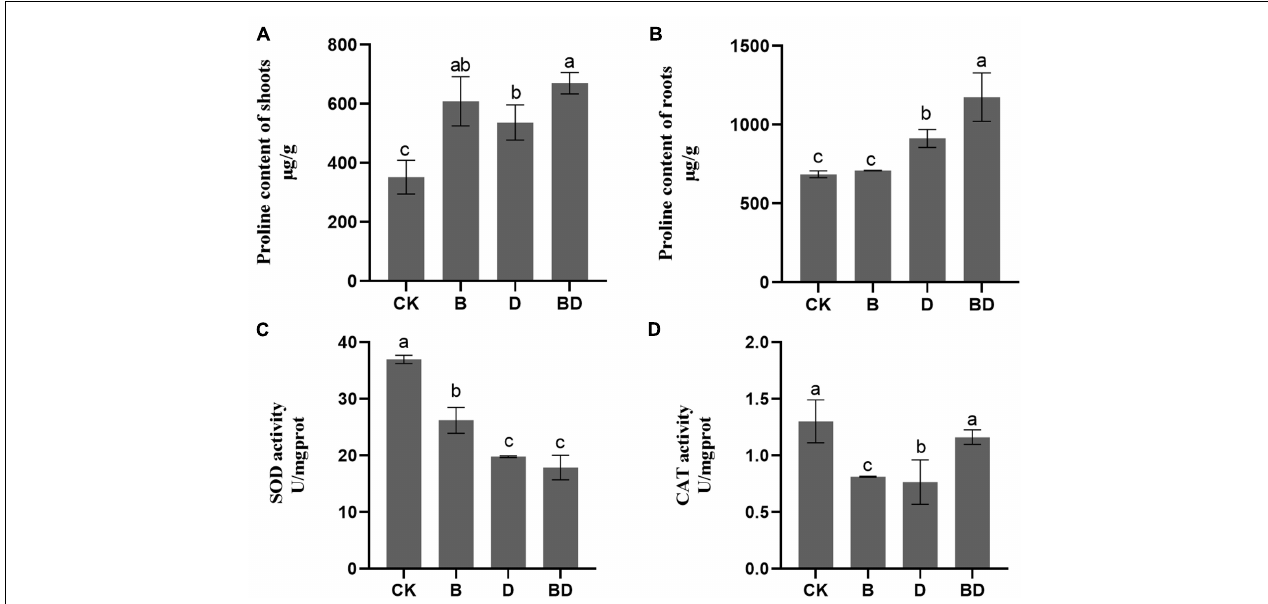
FIGURE 2 | Plant osmotic adjustment solutes’ content and antioxidase activities. The proline content of (A) shoot and (B) root tissues, and the (C) SOD and (D) CAT activities of Glycyrrhiza uralensis ( F -value = 15.1, 24.1, 85.9, 10.5). Bars are the mean ± SE ( n =